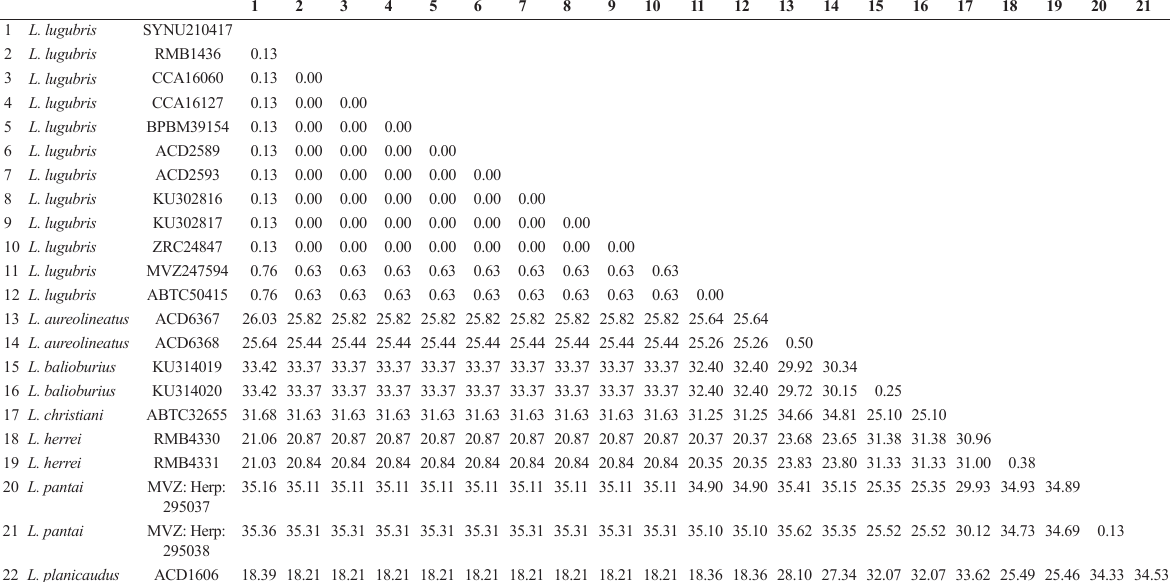
Table 2. Uncorrected P -distance of ND2 gene among seven Lepidodactylus species used in this